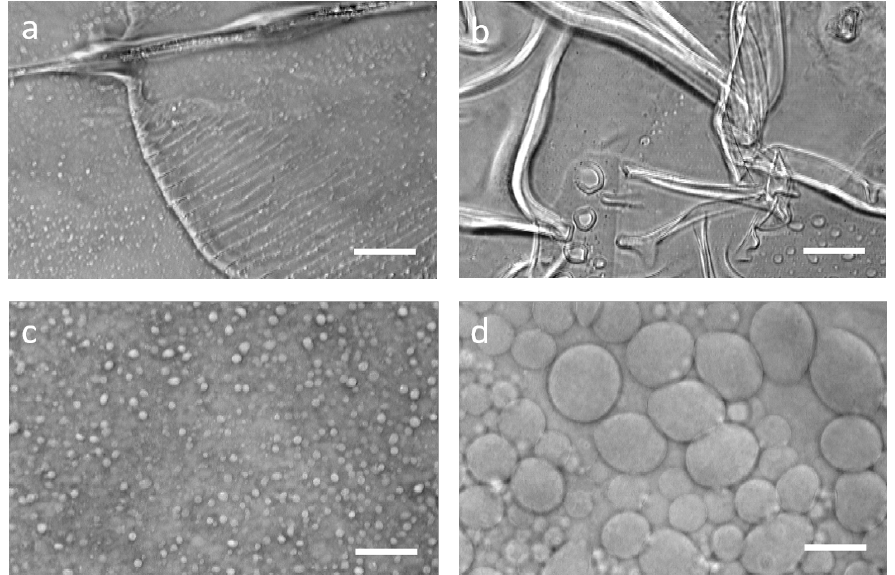
Figure 2. PVA-assisted swelling. Examples of folds ( a ) and cracks ( b ) of the PVA layer, leading to no swelling (if folds) or low-yield swelling (if too many cracks). Images of GUVs during PVA-assisted swelling at t = 2 min ( c ) and t = 15 min ( d ). Scale bars: 10 µ